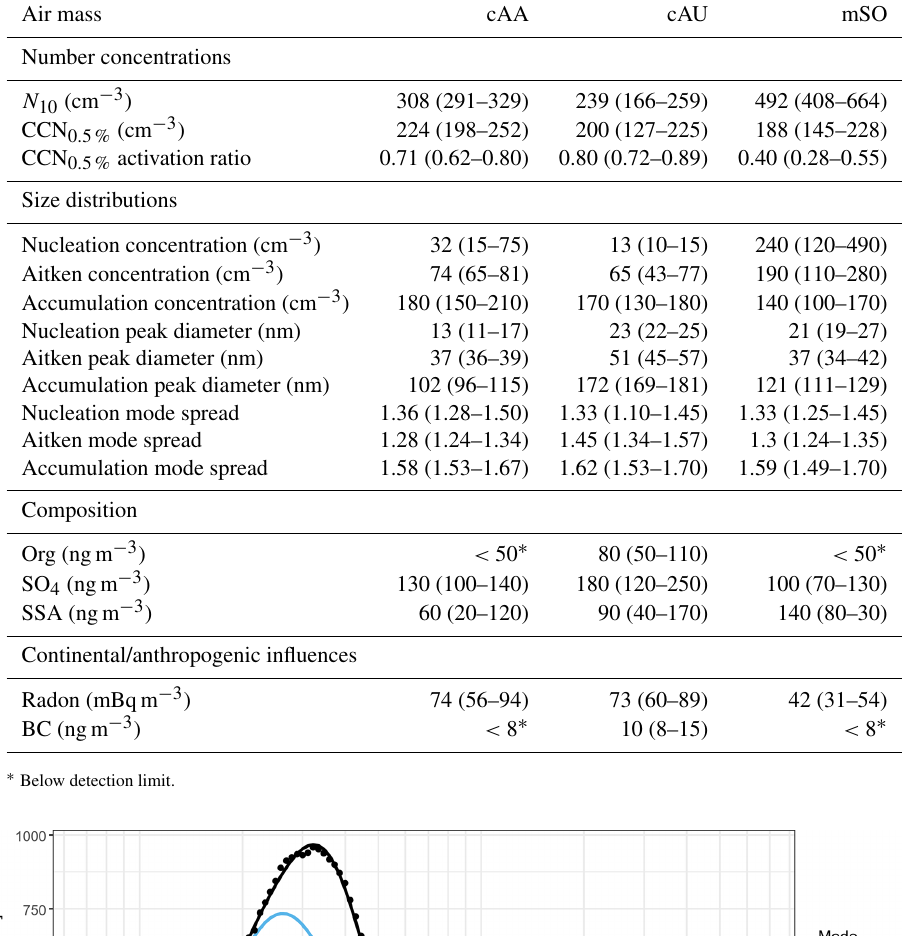
Table 1. Physical properties observed for the three air mass classifications, including continental Antarctic (cAA), continental Australian (cAU), and maritime Southern Ocean (mSO). The values represent the median for each air mass, with the interquartile range provided in parentheses.